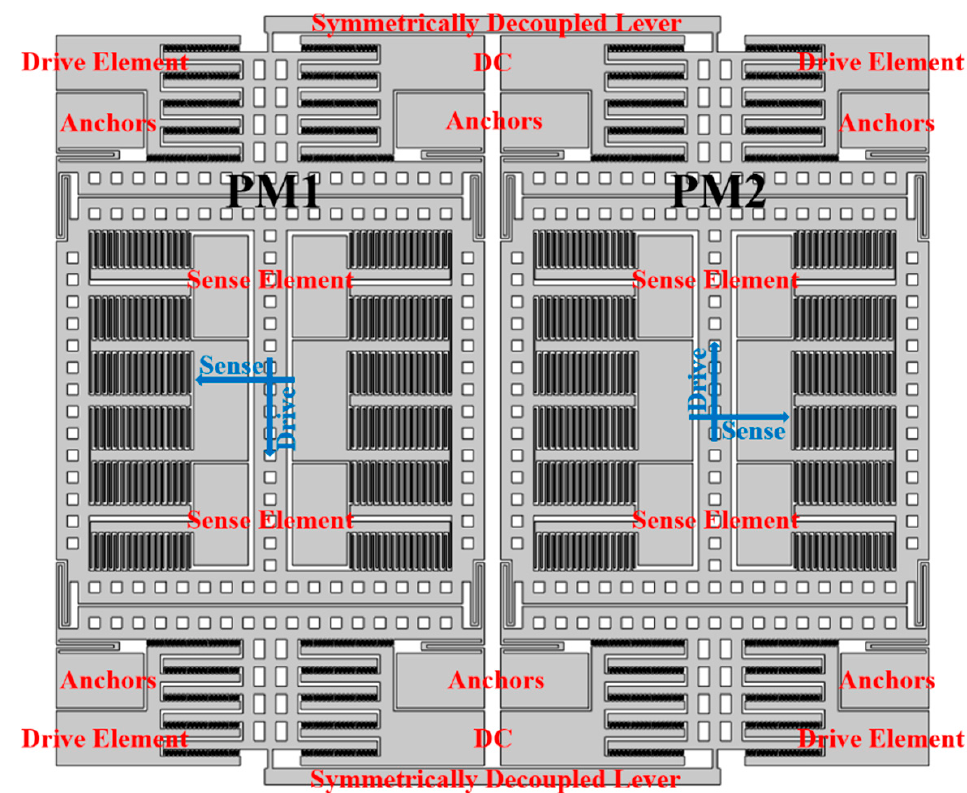
Figure 1. A schematic illustration of the dual − mass TFG sensing element.